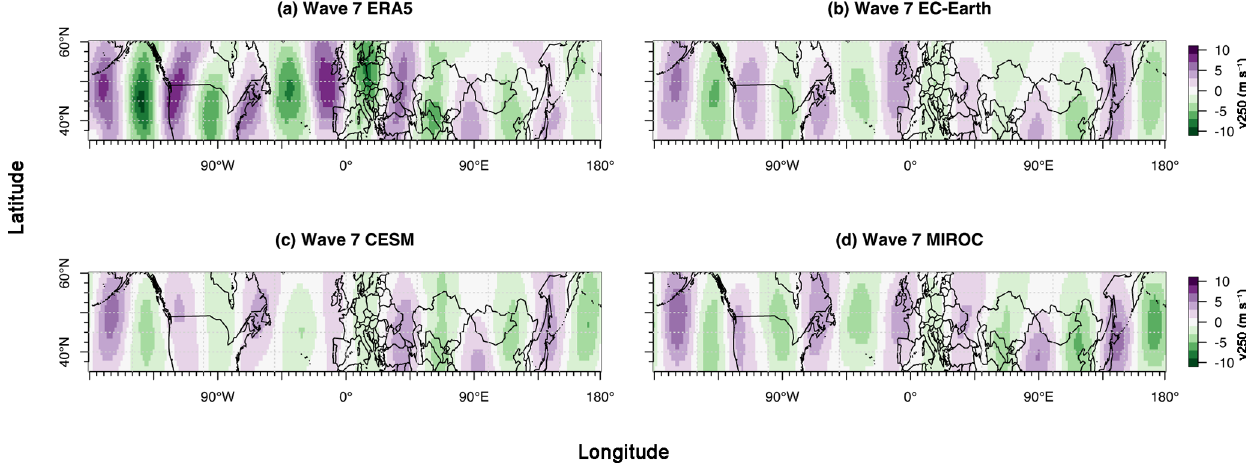
Figure B11. Composite anomaly plots of weeks with high-amplitude wave-7 episodes for meridional wind velocity at 250hPa (v250, anomaly) in ERA5 (a) , EC-Earth (b) , CESM (c) , and MIROC (d) based on the AISI control runs.